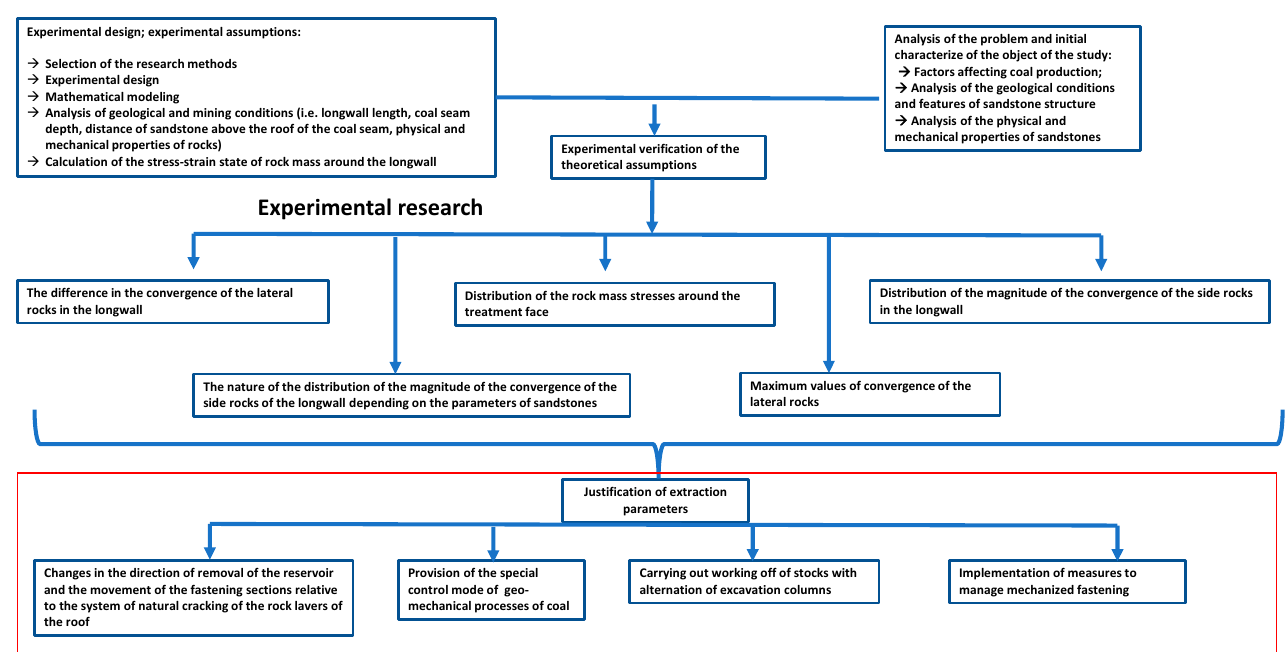
Figure 1. Structural and logical scheme of the study (a red frame outlines a structural-logical scheme of the research).